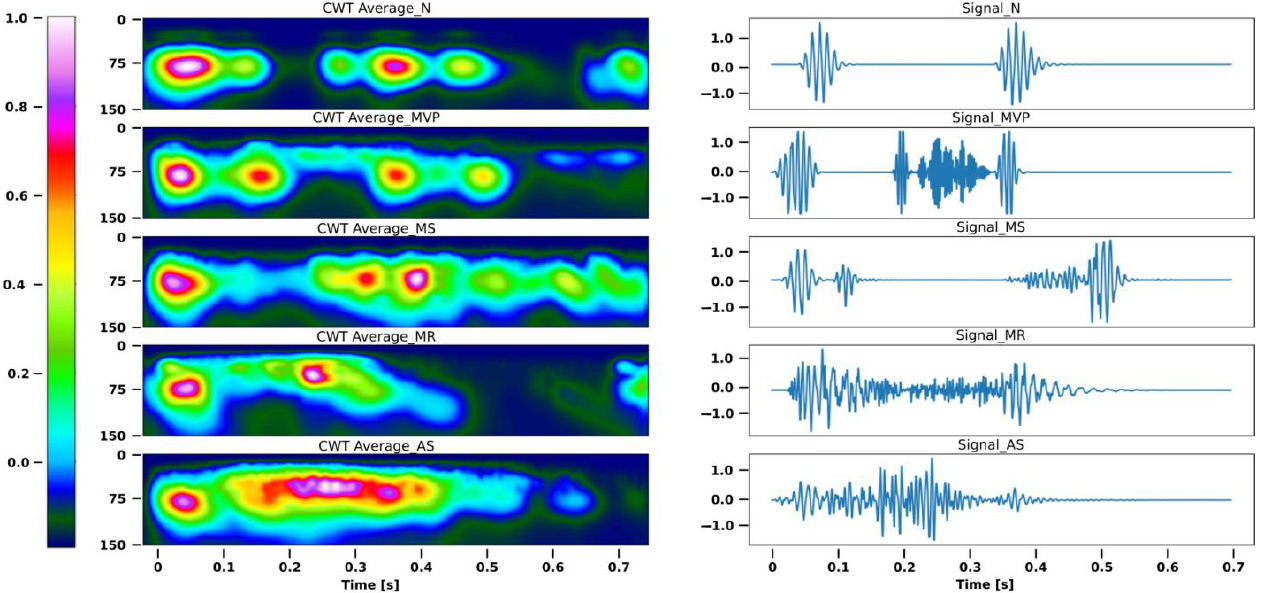
Figure 5. DWT outcomes display the averaged value of the coefficients for each class set with 150 scales, for each scale at each time point, on a colorimetric scale (reused with permission [27]). Hilbert transform: It is well-known that, when applied to the signal a priori, the Hilbert transform can enhance the DWT’s multiresolution framework [27 – 29].